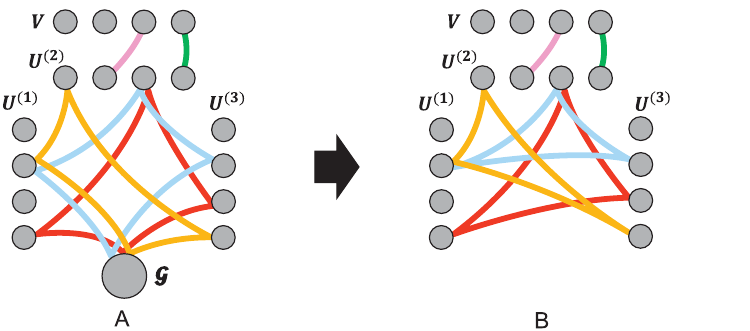
Fig 3. Example hypergraphs induced by S 3 CMTF objective function (Eq (7)). A matrix Y is coupled to the second mode of X with a coupled factor matrix V . Each node represents a factor row or the core tensor. Each hyperedge includes corresponding factors to an SGD update. (a) Induced hypergraph with the core tensor. Every hyperedge corresponding to tensor entries includes G . (b) Induced hypergraph without core tensor. The graph has sparse structure as every node is shared by only few